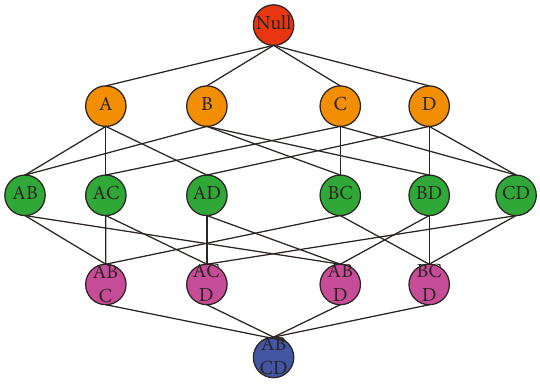
Figure 1: Lattice structure of frequent itemsets. Table 1: Commodity purchase